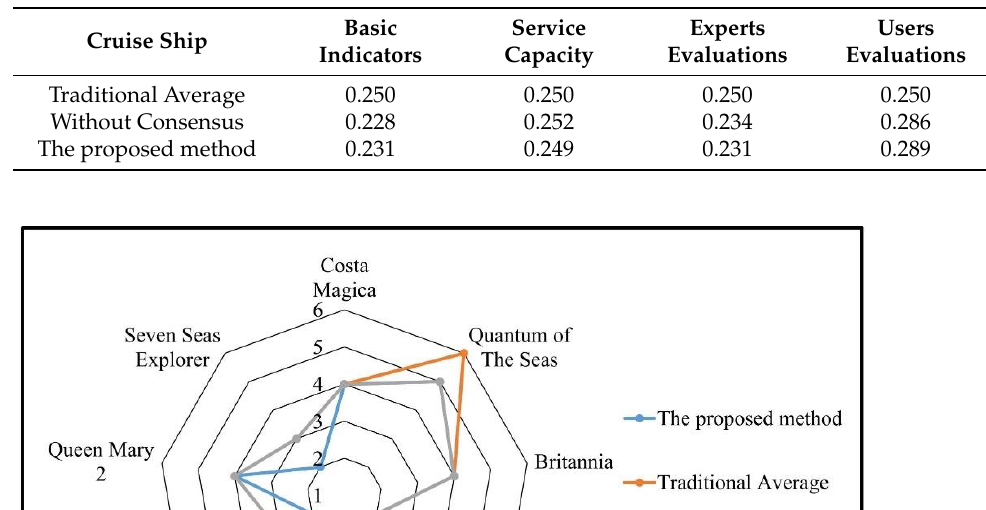
Table 14. Indicator weights analysis under different mechanisms.